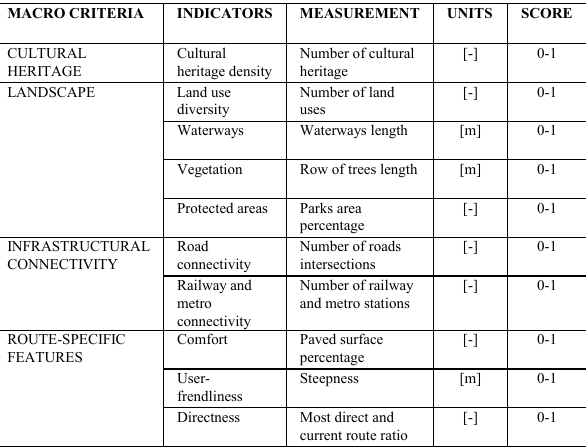
Table 1. Table of selected macro criteria and indicators.